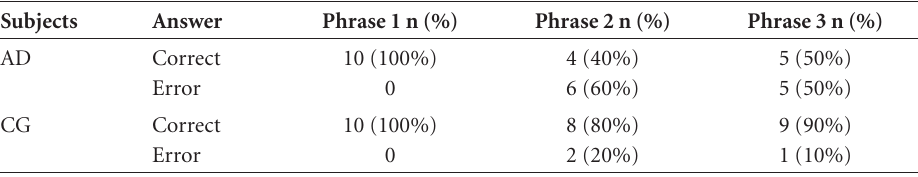
Table 3. Scores of both groups on repetition phrases of the MMSE and